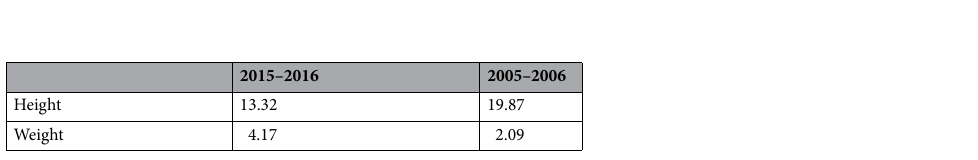
Table 2. Digit preference scores for height and weight measurements of the NFHS-3 and NFHS-4